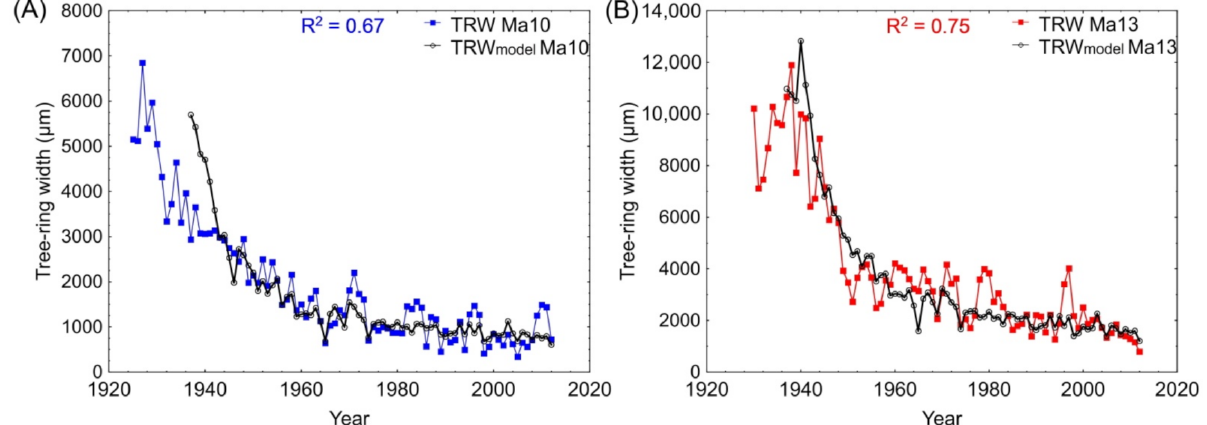
Figure 10. Variations of observed and simulated tree-ring width (TRW) (in) for Ma10 (R 2 = 0.67) ( A ) and Ma13 (R 2 = 0.75) ( B ) over